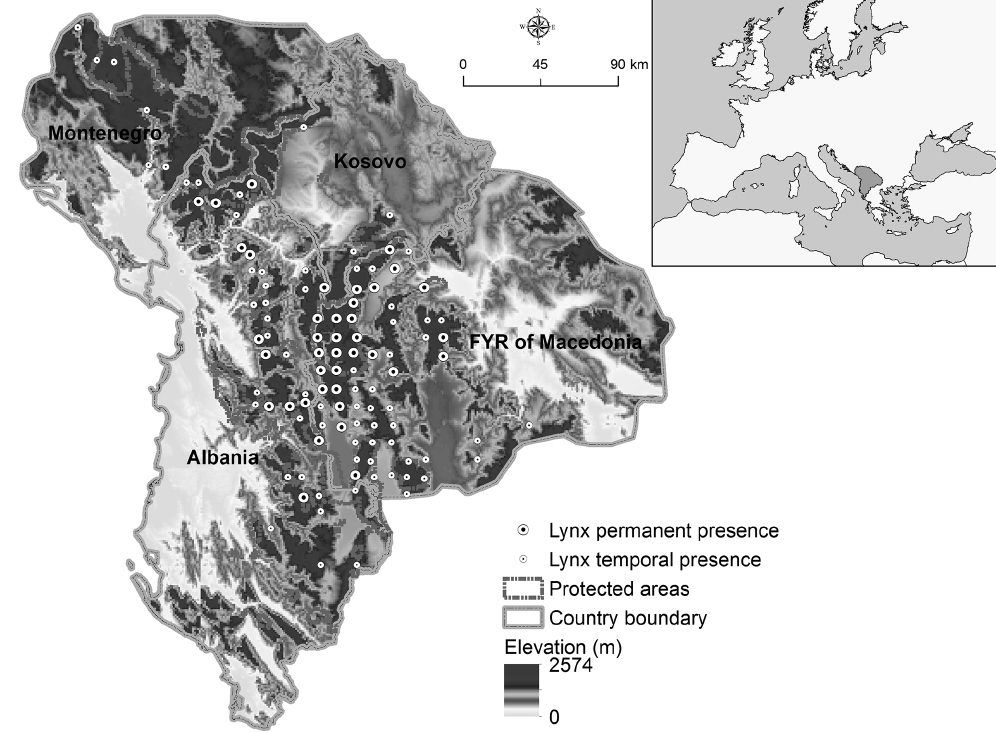
Figure 1. Locations of 109 lynx occurrence records in the study area. Data were collected by the Balkan Lynx Recovery Programme.